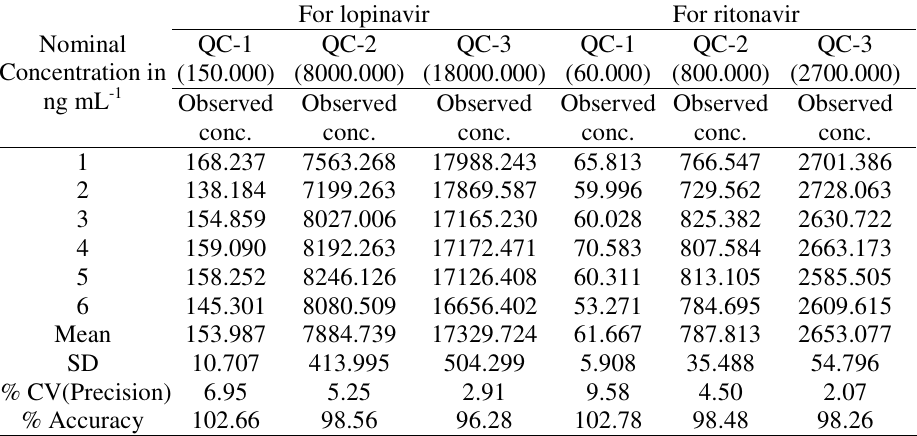
Table 1. Data of precision and